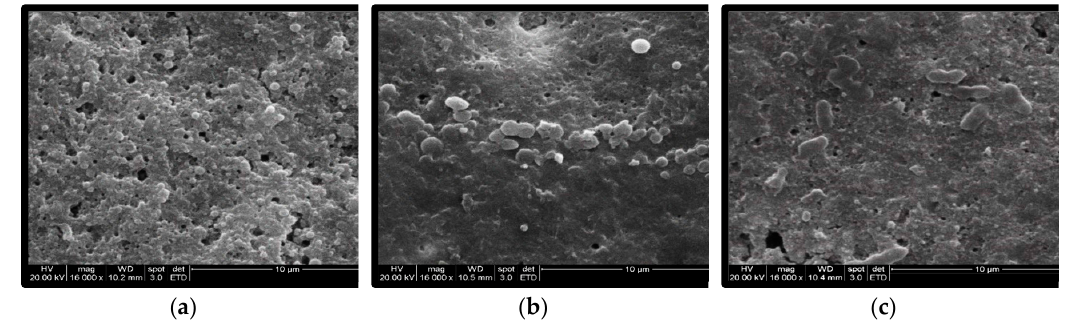
Figure 4. SEM observation of the inoculated eggshells (×16,000 magnification): ( a ) Unwashed, ( b ) PAW 60 s, ( c ) PAW 90 s.